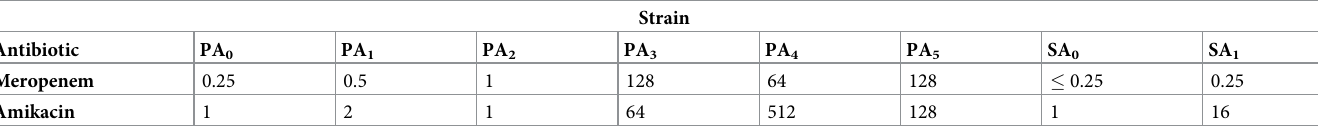
Data indicate the antibiotic concentrations in μ g/ml. MBC was determined for five susceptible strains including SA 0 , SA 1 , PA 0 , PA 1 , and PA 2 . The susceptible isolates were chosen to perform antibiotic assays for co-cultures and biofilms. Cut-off values defining susceptibility for meropenem and amikacin are � 2 and � 16, respectively